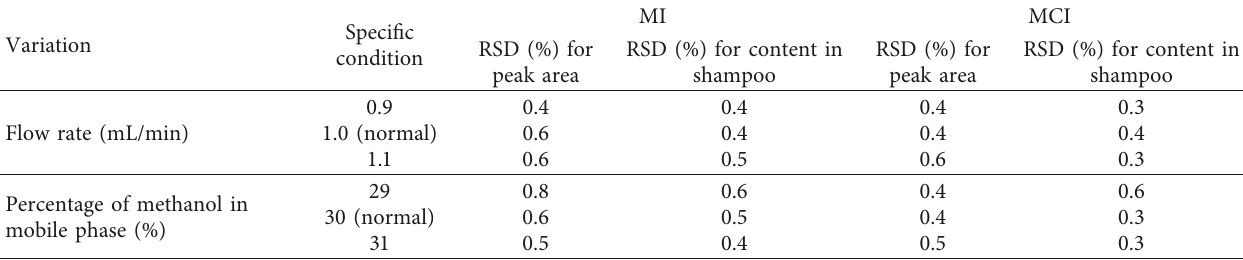
Table 6: Results of robustness.